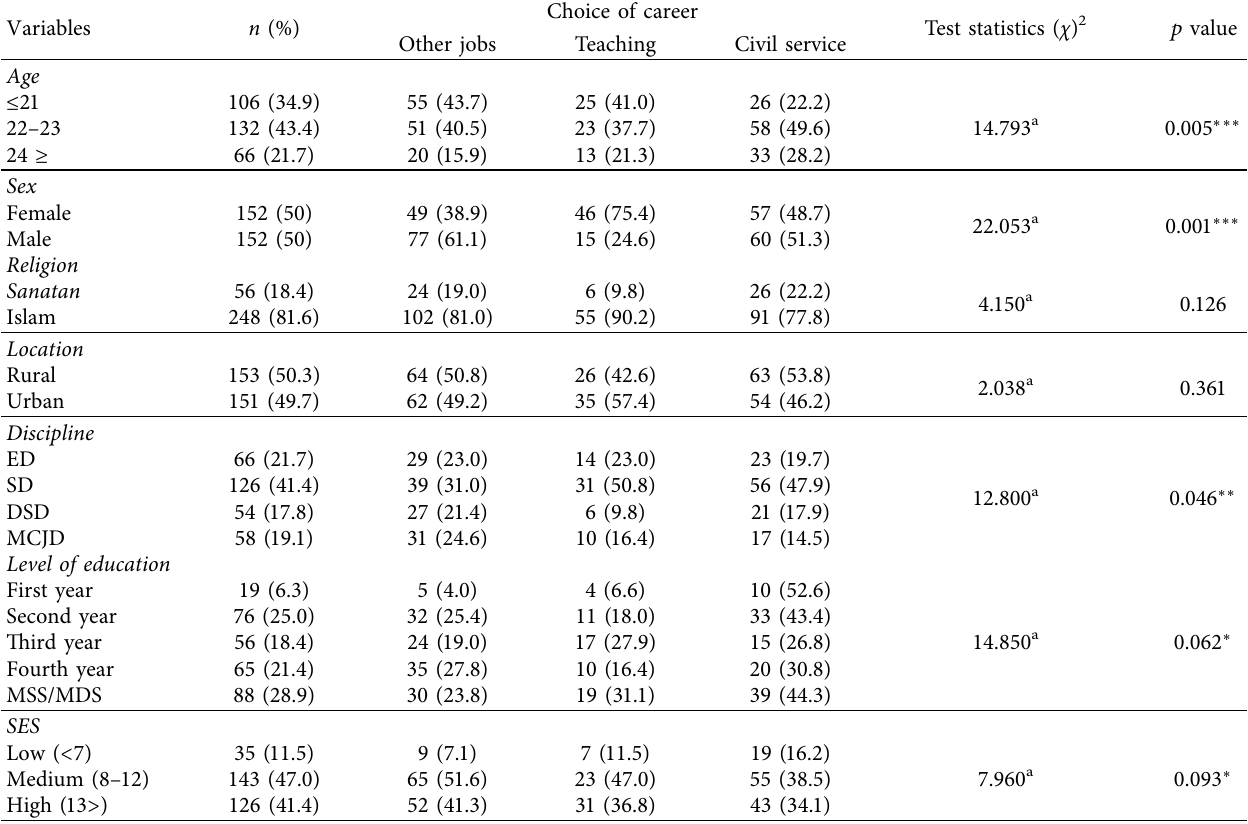
Table 1: Characteristics of the participants and their association with career choice.